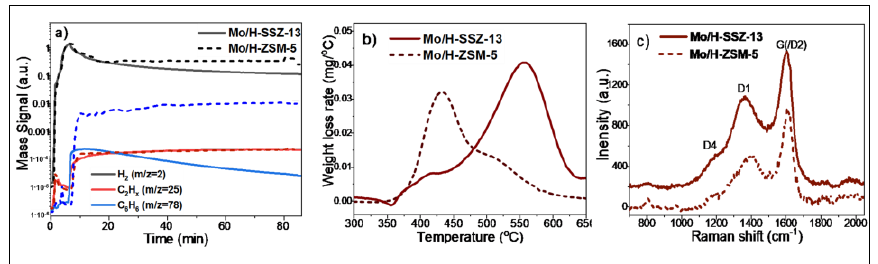
Figure 5. ( a ) MS data under methane dehydroaromatisation reaction products collected for Mo/H-SSZ-13 Figure5. ( a )MSdataundermethanedehydroaromatisationreactionproductscollectedforMo / H-SSZ-13 and Mo/H-ZSM-5 (50% CH 4 /Ar, 1500 h −1 , 700 °C, 90 min); the data are shown in logarithmic scale, and all and Mo / H-ZSM-5 (50% CH 4 / Ar, 1500 h − 1 , 700 ◦ C, 90 min); the data are shown in logarithmic scale, and all signals are normalised to the carrier gas signal (Ar); ( b ) The derivative of the TGA curves for the catalysts recovered after 90 min of reaction; and ( c ) Raman spectra for the catalysts recovered after 90 min of